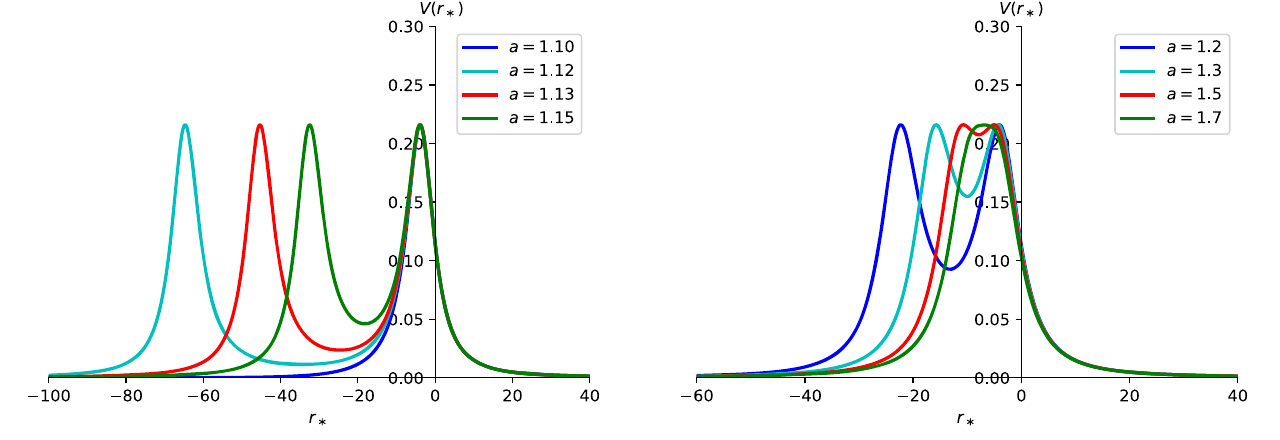
Fig. 2 The effective potential of the electromagnetic field perturbation for different a with M = 0 . 5 , l = 1 , L = 0 .